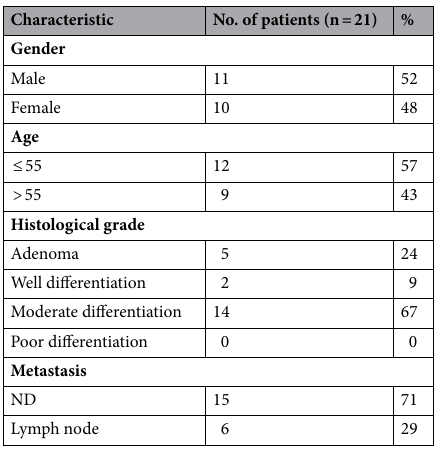
Table 1. Clinical information of colorectal cancer